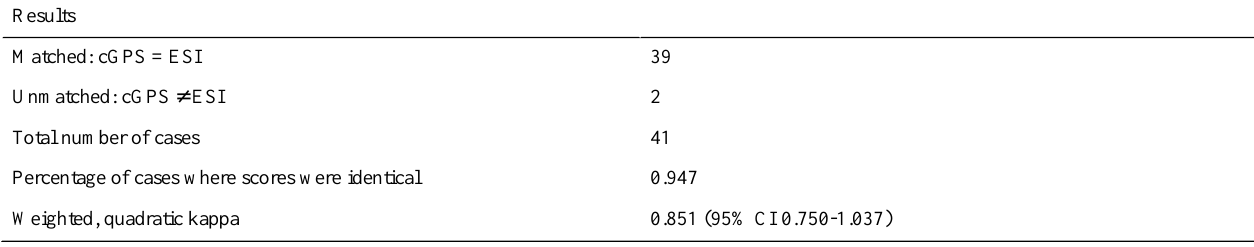
Table 4. Subgroup analysis of case vignettes determined to be severity level 1 or 2 by the ESI system (n=41).